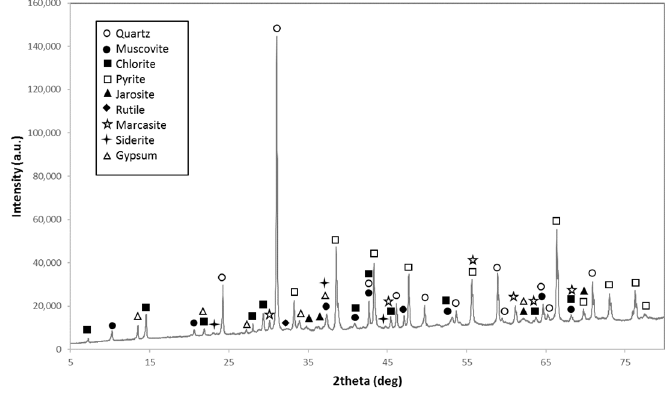
Figure 3. XRD scan of the Freiberg tailing sample (FR_01).